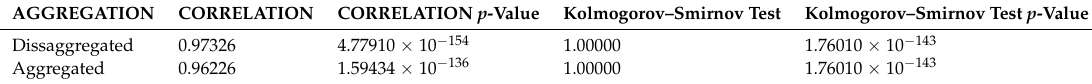
Table A4. This table shows the correlation and Kolmogorov–Smirnov test for Figure 6.